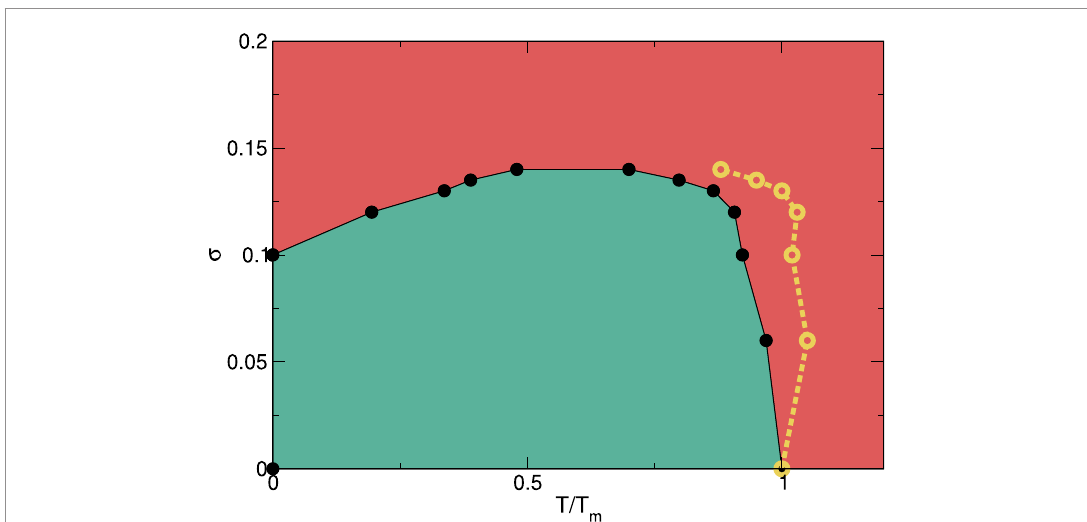
Figure 6. Phase diagram as a function of pinning strength σ vs reduced temperature T / T m constructed from the features in figure 4 for a system with n p = 0 . 25. Green indicates the ordered regime and red indicates the disordered regime. Reentrant ordering occurs for 0 . 1 < σ < 0 . 14. The peak effect appears between the disordering transition and the thermal melting regime, and the dashed line indicates the end of the peak effect window.